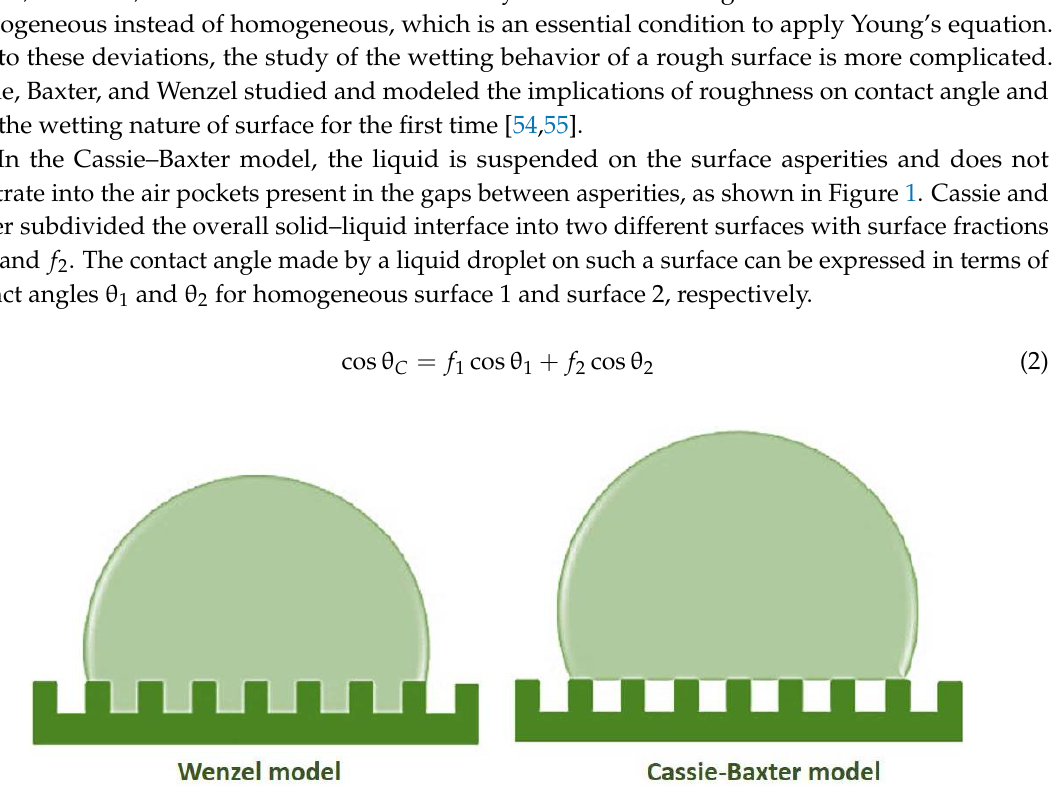
Figure 1. Wenzel model and Cassie–Baxter model of wetting regimes.